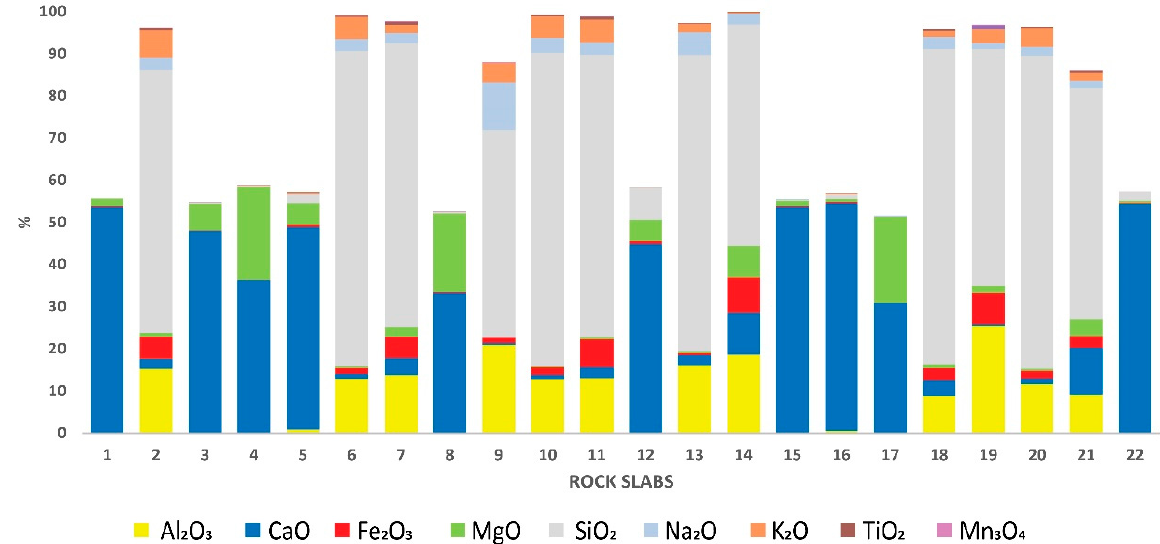
Figure 3. Results of whole-rock geochemical analysis for the 22 rock slabs in oxides. Samples dominated by CaO (blue colour) are marbles. Samples dominated by SiO 2 (grey colour) are plutonic rocks (mainly granitoids). Detail on rock slab lithology is given in Figure 4. (Note: Loss on ignition (LOI) is not reported here. It is expected that carbonate-dominated samples will have high LOI (~40–50%) due to CO 2 generation during heating.